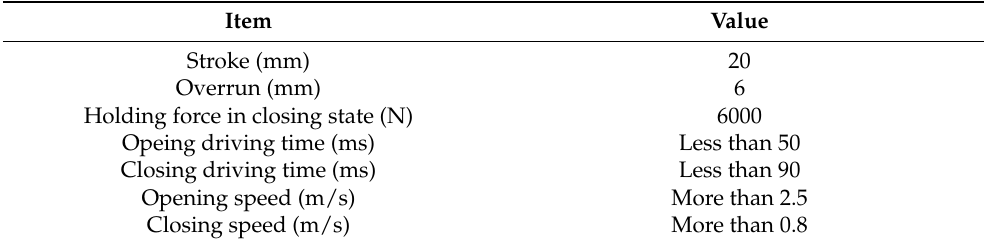
Table 1. Specification of 40.5 kv vacuum circuit